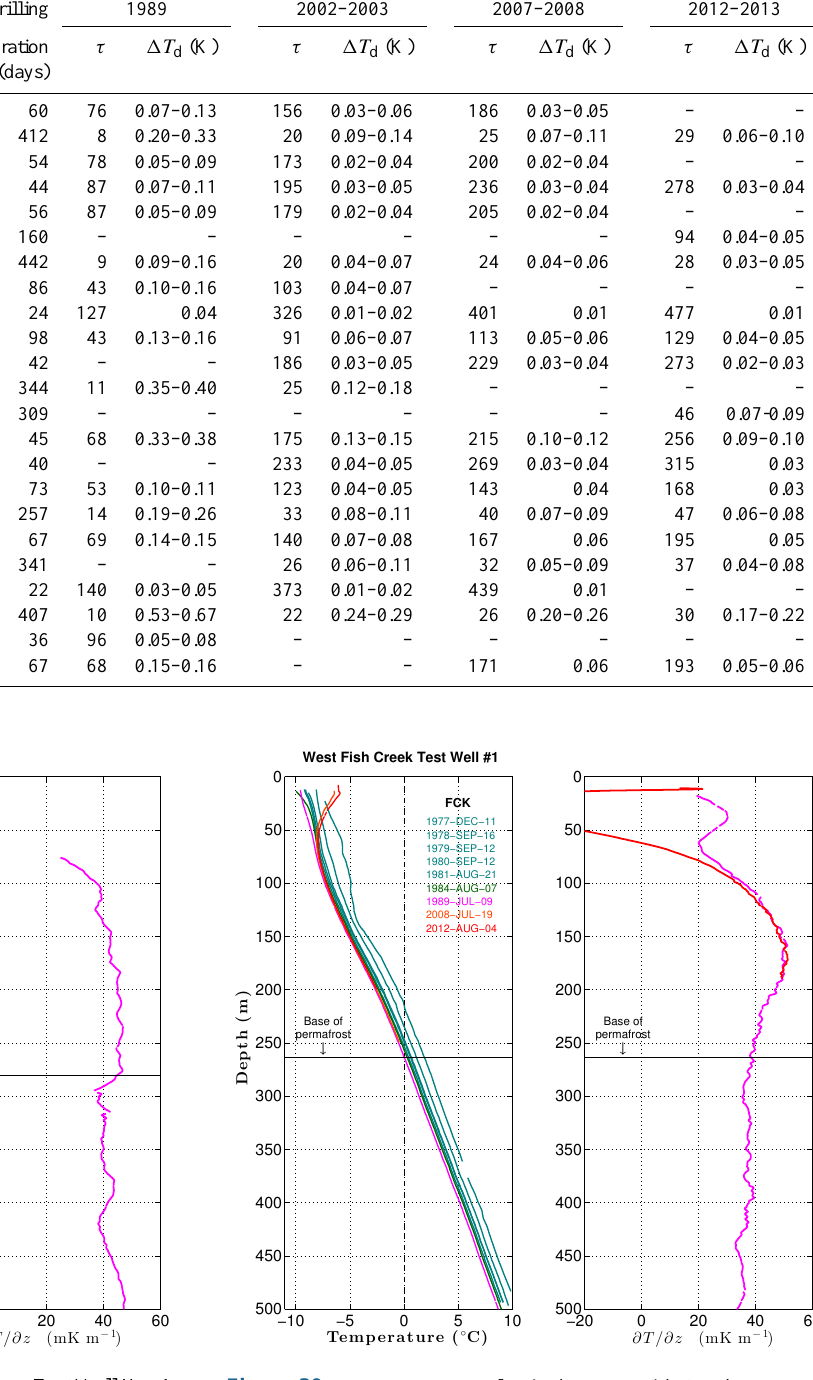
Figure 29. Temperature profiles in the West Dease Test Well No. 1, Figure 30. Temperature profiles in the West Fish Creek Test Well Temperature profiles in the West Dease Test Well No. 1, color-coded by acquisition date (left). Temperature gradient calculated Figure 29. Figure 30. Temperature profiles in the West Fish Creek Test Well No. 1, color-coded by acquisition date (left). Temperature gradients color-coded by acquisition date (left). Temperature gradient calcu- No. 1, color-coded by acquisition date (left). Temperature gradients from the 1989 log is shown in the right panel. calculated from the 1989 and 2012 logs are shown in the right panel. lated from the 1989 log is shown in the right panel. calculated from the 1989 and 2012 logs are shown in the right